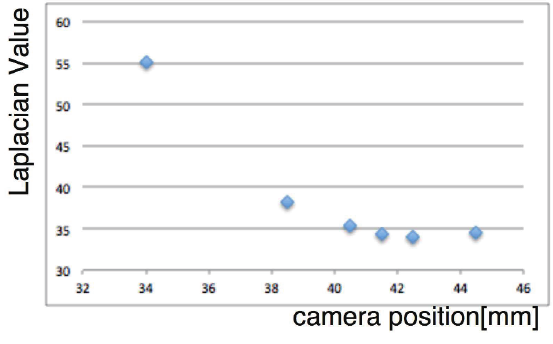
Figure 4. Position dependence of the Laplacian